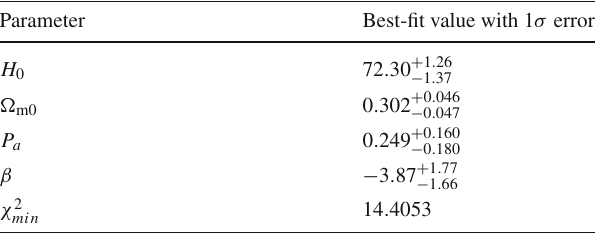
Table 3 Best-fit parameters H 0 , (cid:3) m0 , P a and β from CC datasets. Here we also list χ